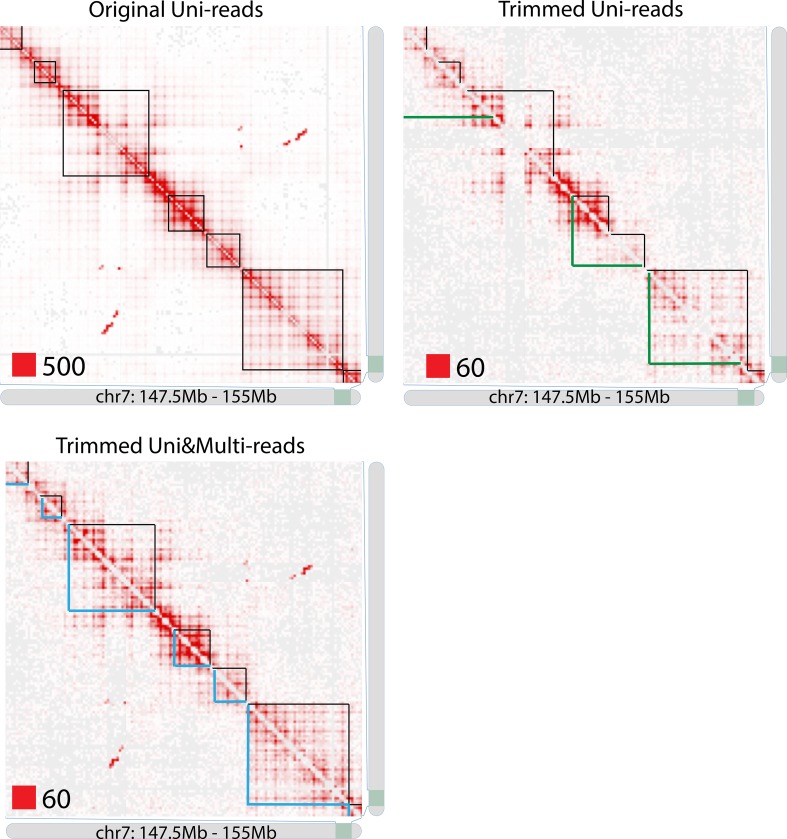
TAD detection on chromosome 7 of original longer uni-reads contact matrix, trimmed uni-reads (36 bp) contact matrix and trimmed uni- and multi-reads (36 bp) contact matrix.